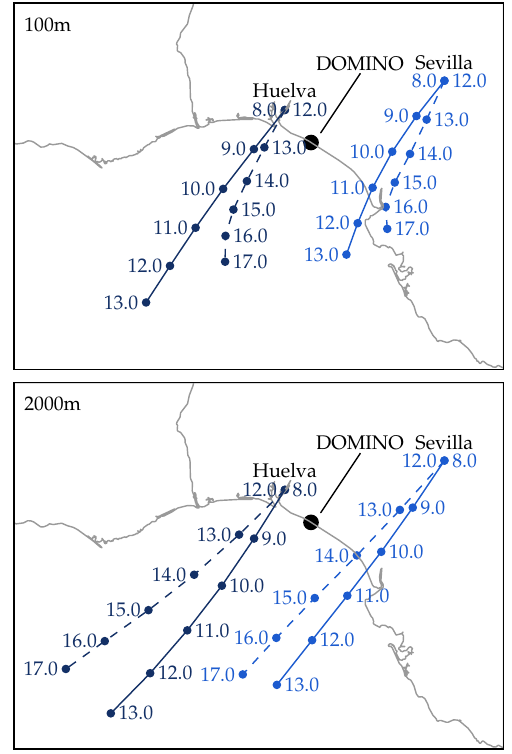
Fig. 2. Forward trajectories at 100m and 2000m calculated by the NOAA HYSPLIT model using NCEP-GDAS meteorology, starting at Sevilla and Huelva at 08:00UTC (solid lines) and 12:00UTC (dashed lines) on 23 November 2008. The black dot indicates the DOMINO measurement location at El Arenosillo. As a refer- ence, the distance between the measurement site (“DOMINO”) and Sevilla is